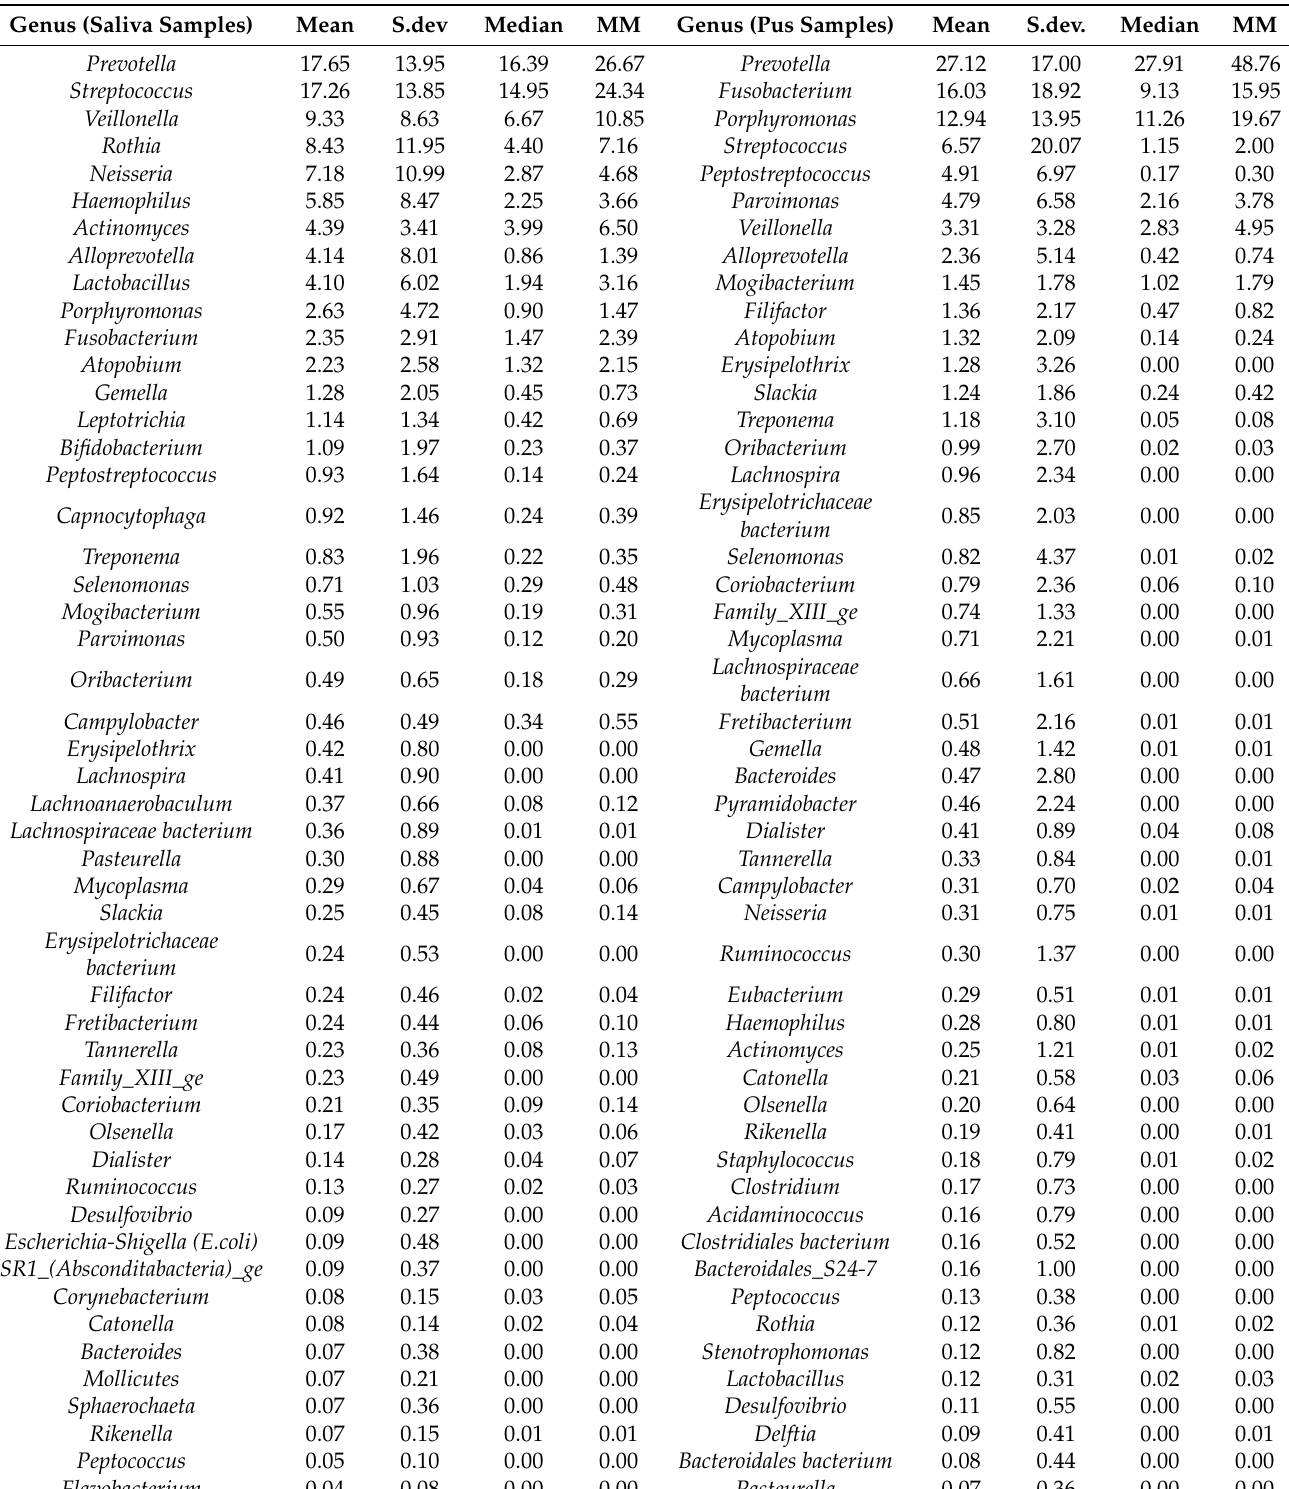
Table 1. Relative frequencies in percent of the 50 most frequently detected bacterial genera in the saliva and pus samples, sorted in descending order according to the mean value. It is obvious that the median deviates often from the mean and thus a normal distribution of the data cannot be assumed. The column “S.dev.” represents the standard deviation and the column “MM” extrapolates the median to 100% and indicates what percentage of a saliva or pus sample can be assigned to a corresponding bacterial